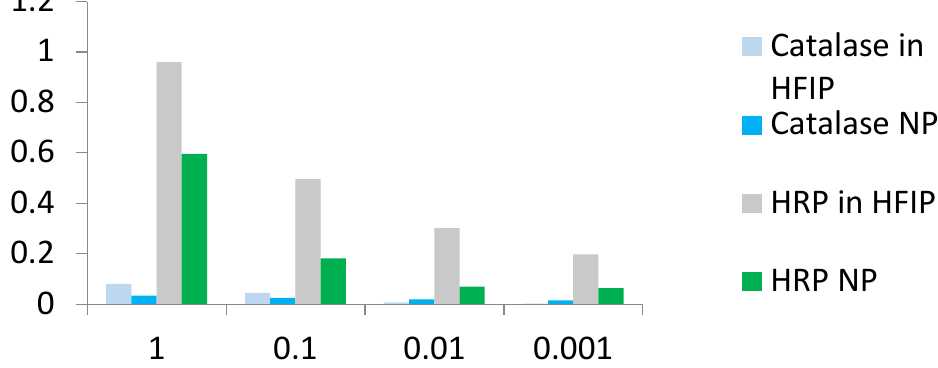
Figure 6. Comparison of enzymatic activity of two antioxidant enzymes in the fluoroalcohol HFIP solution and ENP. Optical density at 450 nm of TMB solution in the presence of H 2 O 2 and catalase in HFIP solution, catalase NP, HRP in HFIP solution or HRP NP.